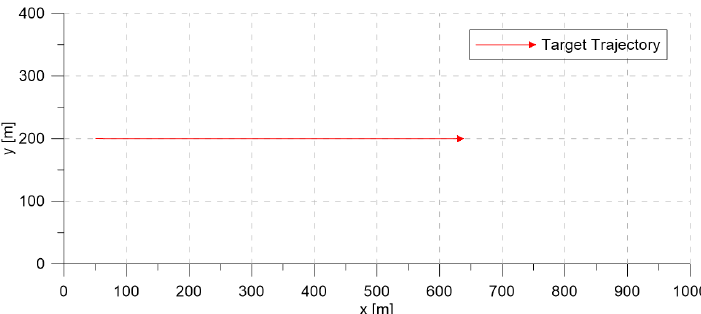
Figure 3. The non-maneuvering target trajectory in the surveillance